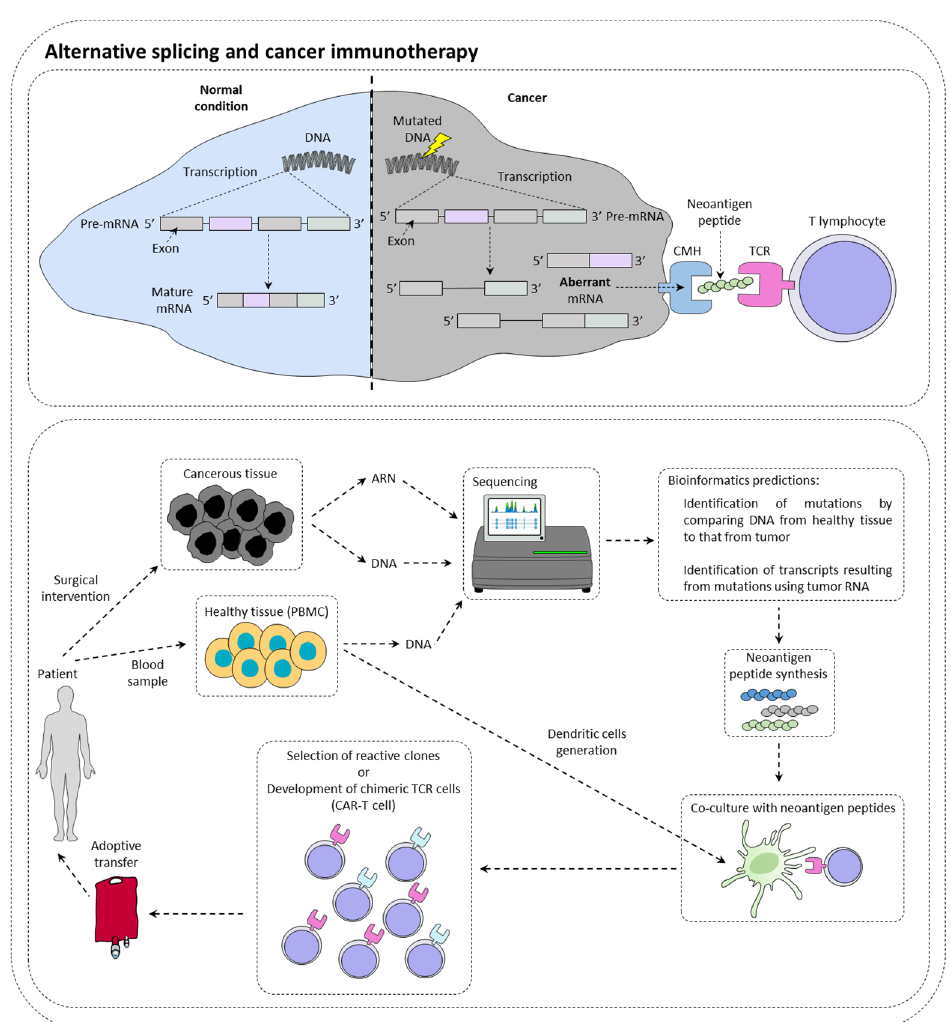
Figure 1. Alternative splicing and cancer immunotherapy. Alternative splicing could have a direct impact on immunotherapy response by creating neoantigen peptide that could be recognized by immune cells. This is currently under investigation for the production of CAR-T cells.